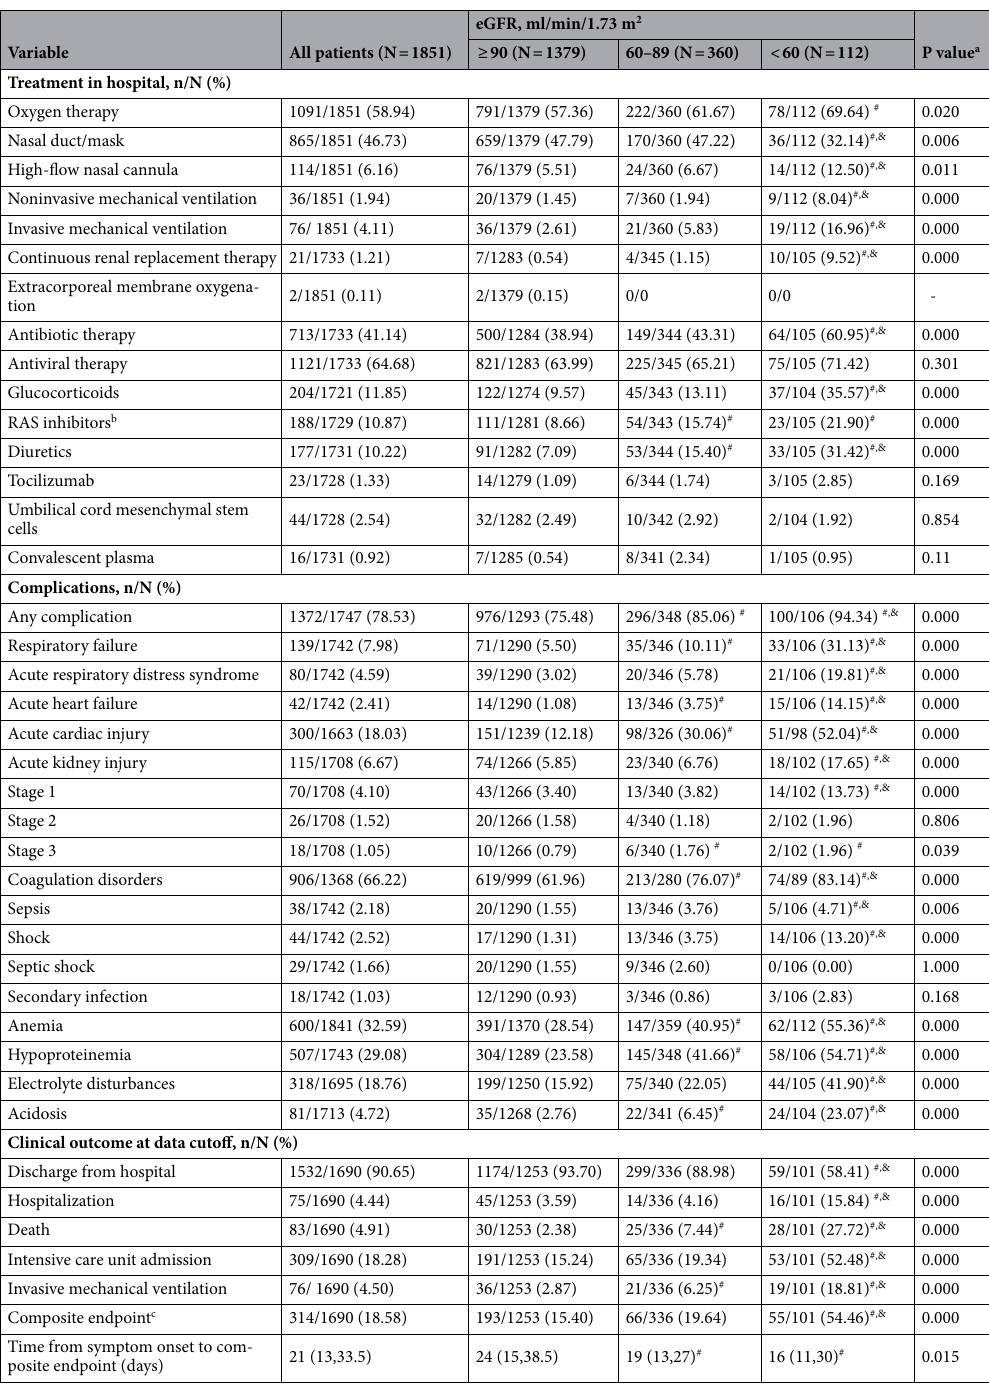
Table 3. Treatment, complications, and clinical outcomes of COVID-19 patients stratified according to eGFR levels. Data are expressed as no./total no. (%). a P values were calculated using the chi-square test. b RAS inhibitors included angiotensin-converting-enzyme inhibitors and angiotensin receptor blockers. RAS, renin- angiotensin system. c The composite endpoint comprised admission to the intensive care unit or mechanical ventilation or death, whichever occurred first. COVID-19, coronavirus disease 2019; eGFR, estimated glomerular filtration rate. # vs GFR ≥ 90 & vs 60 ≤ GFR <